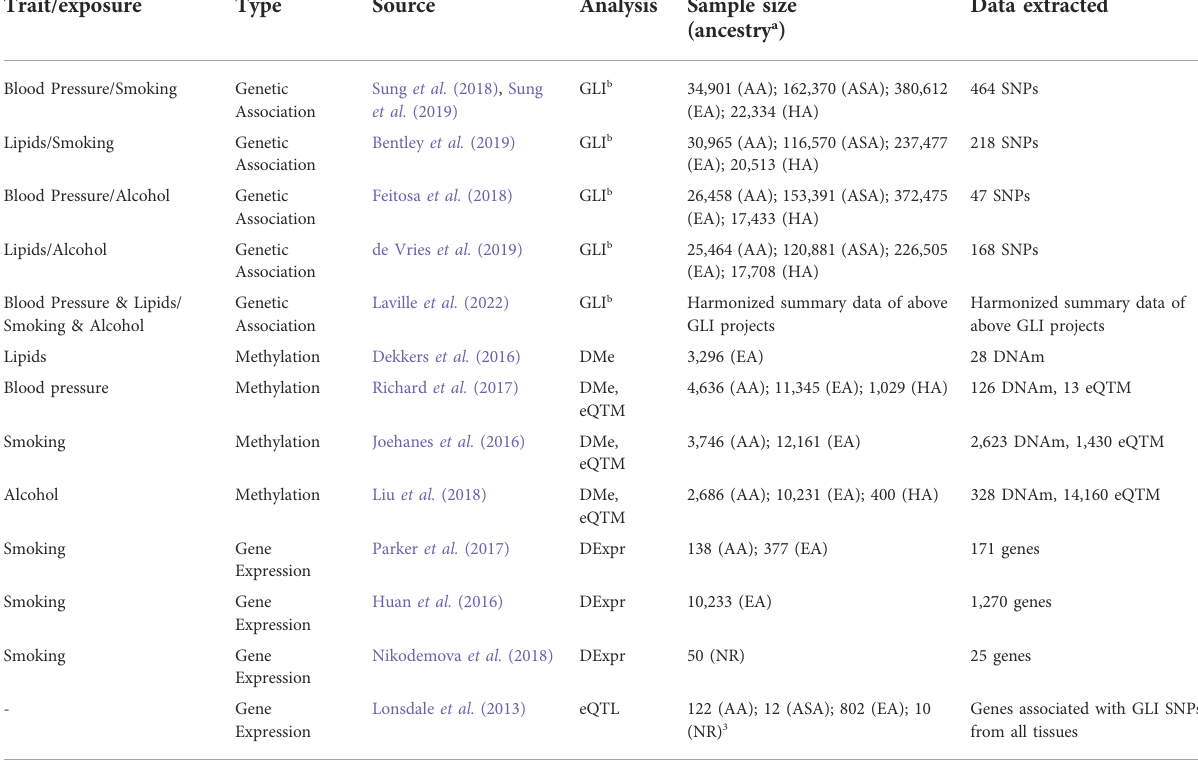
TABLE 1 Data used in locus